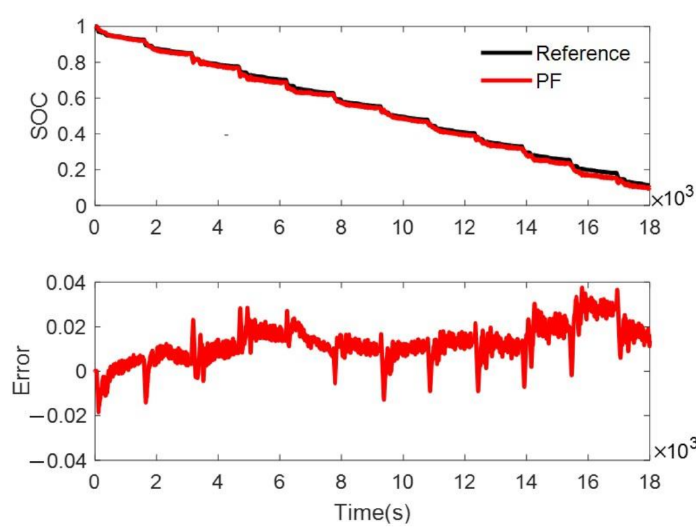
Figure 7. Battery SOC estimation and error curve, based on the PF